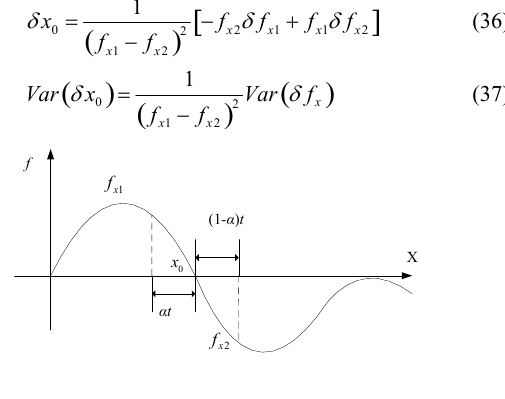
QEWidth (b)std. of Estimation Peak Amplitude (a)Estimation Peak Amplitude for Centered(x=0.6,y=0.1)SSP By QE for Centered(x=0.6,y=0.1)SSP By Figure 7. QE estimation of amplitude when Sinc peak is at x =0.6, y =0.1 with 10dB noise